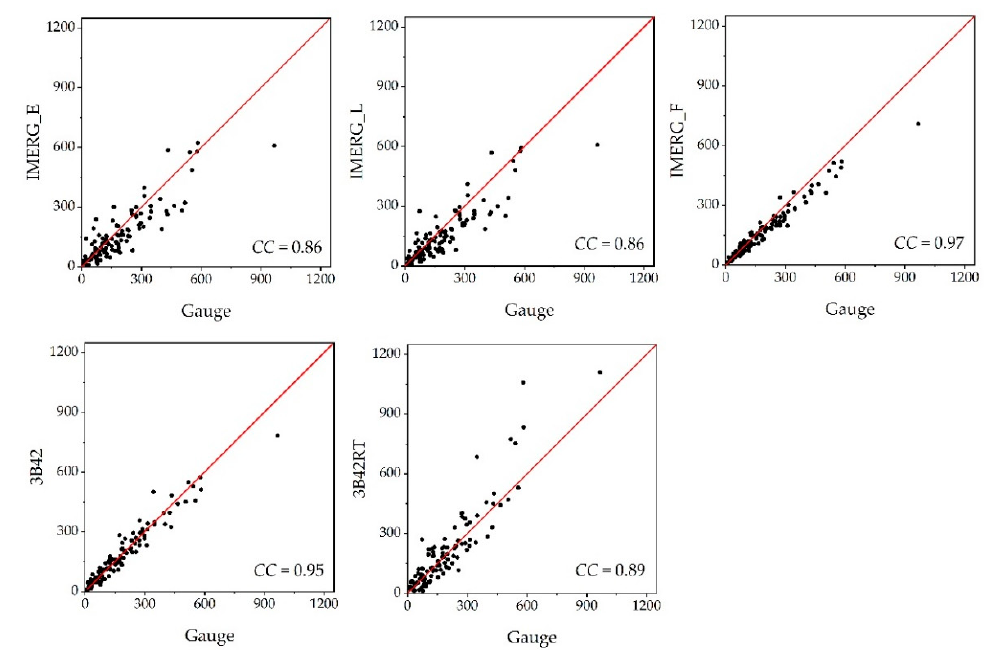
Figure A3. Scatterplots between monthly rainfall gauge observations and satellite precipitation product estimates.